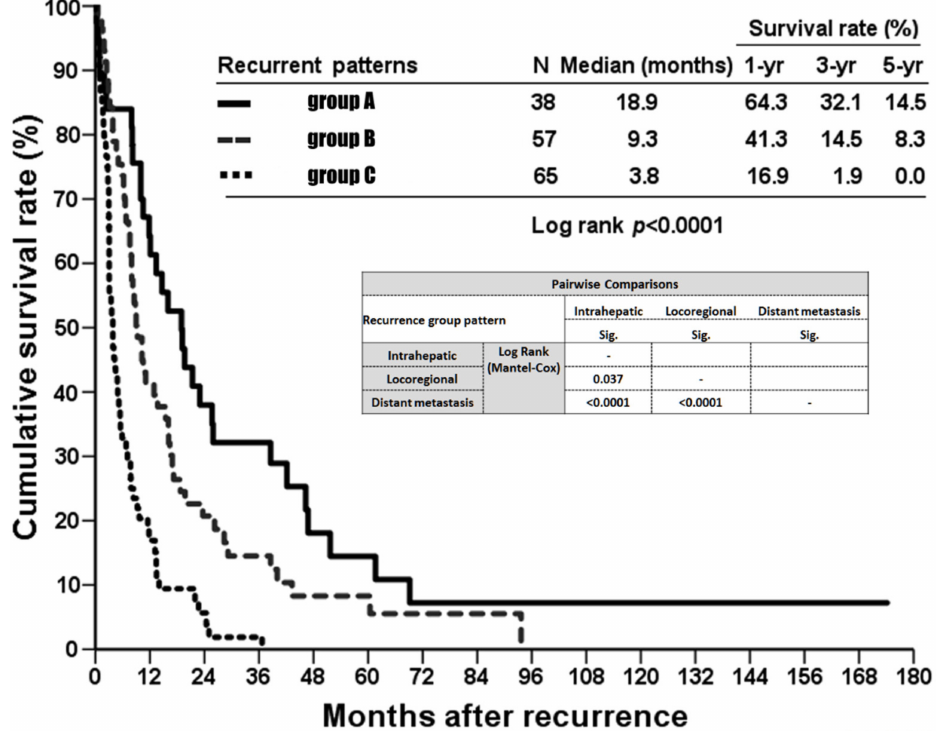
Figure 3. The comparison of overall survival (OS) among the three different recurrent patterns, represented by groups A, B, and